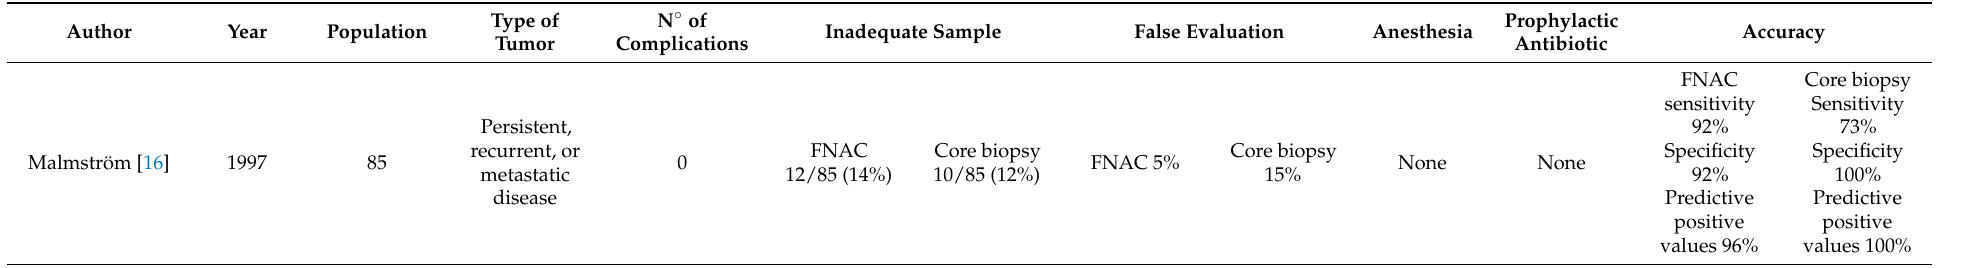
Table 3. Characteristics of patients undergoing FNAC and tru-cut biopsy.